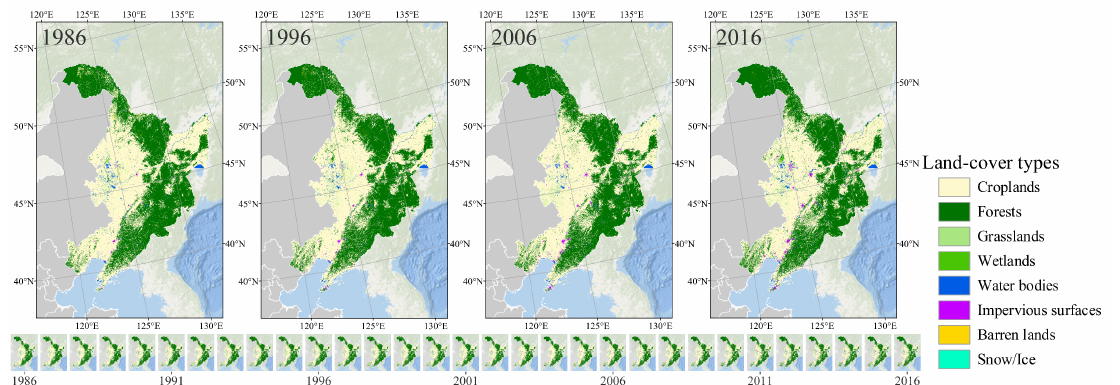
Figure 2. The annual land cover map series of Northeast China based on multi-temporal Landsat imagery. Maps of 1986, 1996, 2006 and 2016 were zoomed in. Note the encroachment of croplands into forests, the variation of wetlands (around 47 ◦ N, 124 ◦ E), and the increase of impervious